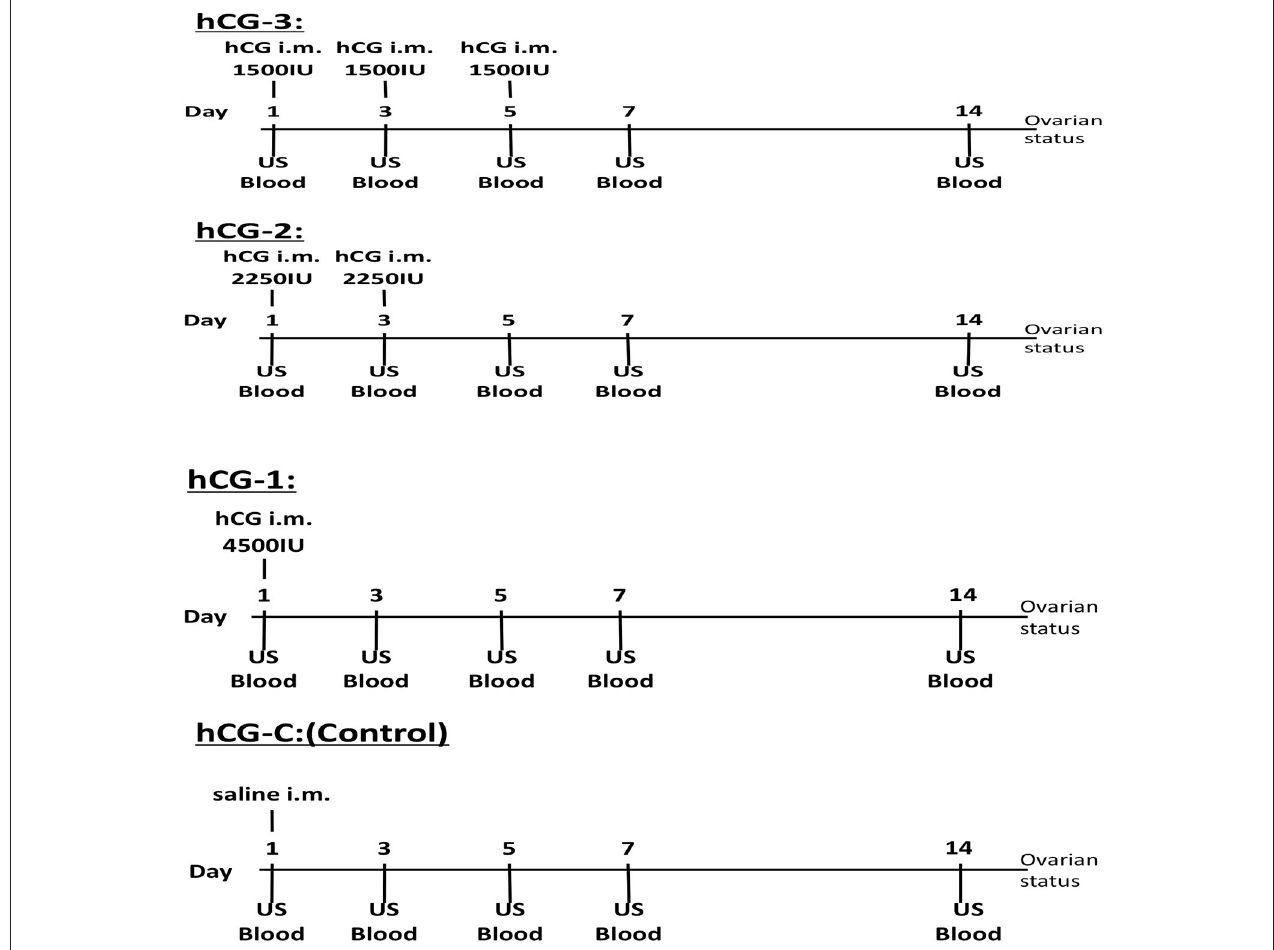
FIGURE 1 | Experimental protocol of the hCG administrations, blood sampling, and ovarian ultrasonographic examination for each